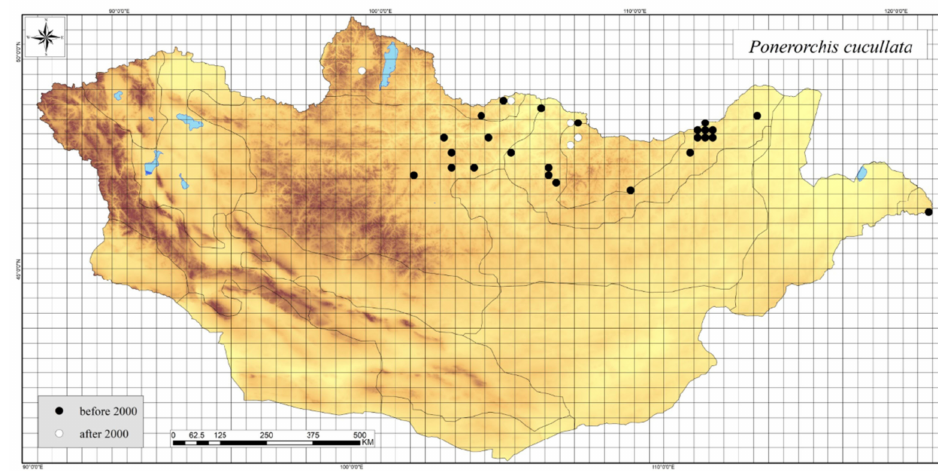
Figure A25. Distribution map of Ponerorchis cucullata in Mongolia.